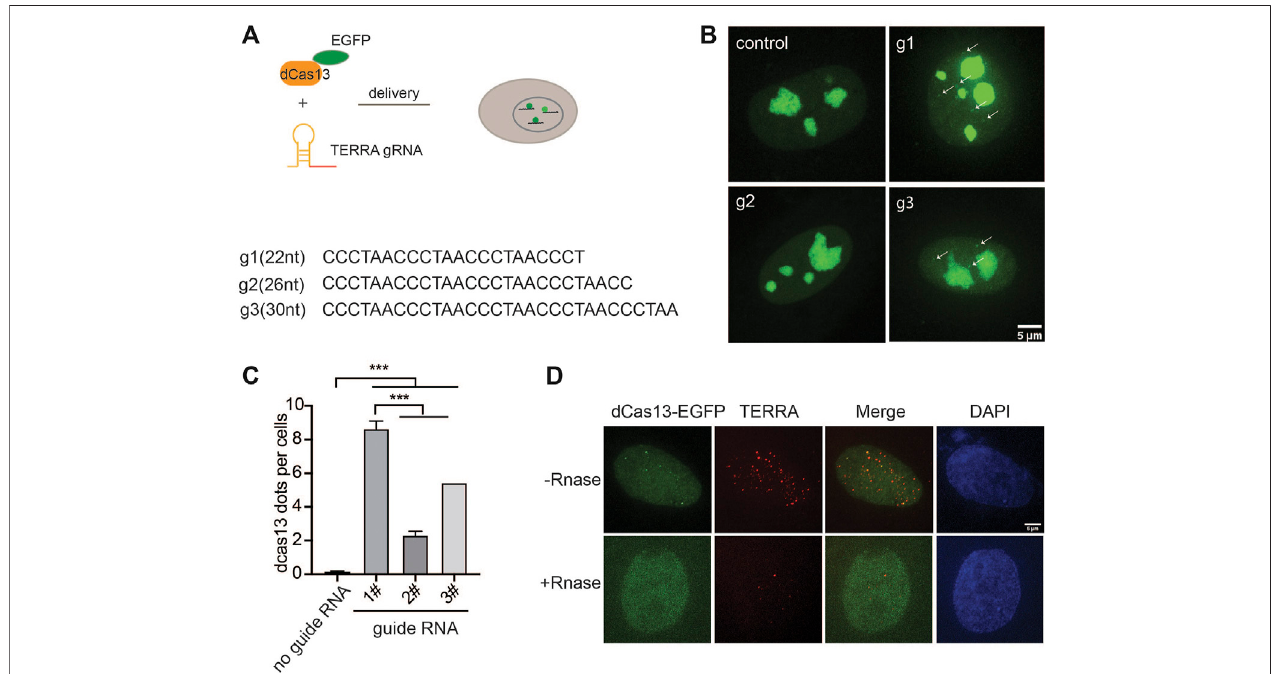
FIGURE1| CRISPR-dCas13enablesvisualizationofTERRAinlivecells. (A) OverviewofCRISPR-dCas13-mediatedTERRAlabeling. (B) Representativeimagesof dCas13b-EGFP with threedifferentguide RNAs forTERRA and guide fornon-target control RNA. Arrows indicate dCas13b-EGFP labeled TERRA. (C) Quanti fi cation of totalfocipercellindicatedbydCas13withdifferentguideRNAs(mean ± SEM,unpaired t -test).N ≥ 100foreachgroup.*** p < 0.001. (D) RNAFISHshowscolocalization of dCas13b-EGFP with TERRA foci (red). DAPI detects nuclear DNA.